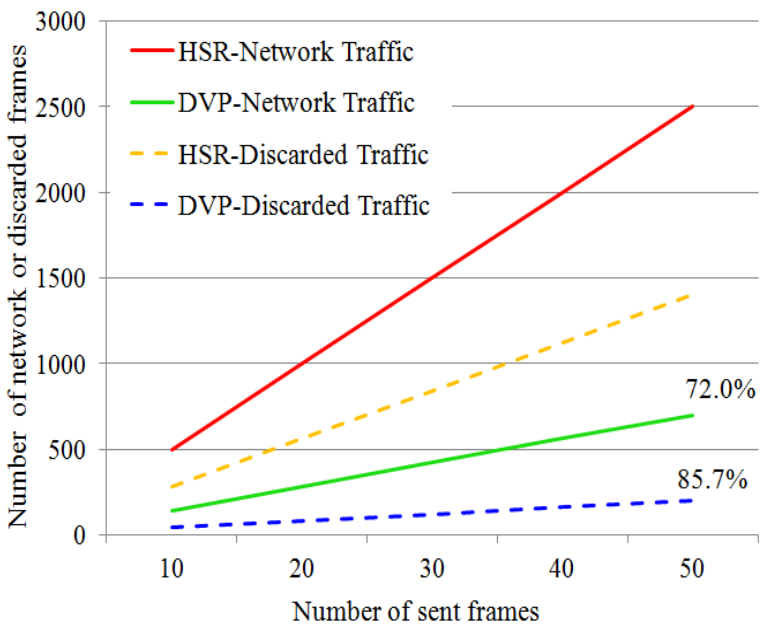
Figure 8. Network traffic and discarded traffic comparison between the HSR protocol and DVP algorithm under the first experiment: node-failure case.